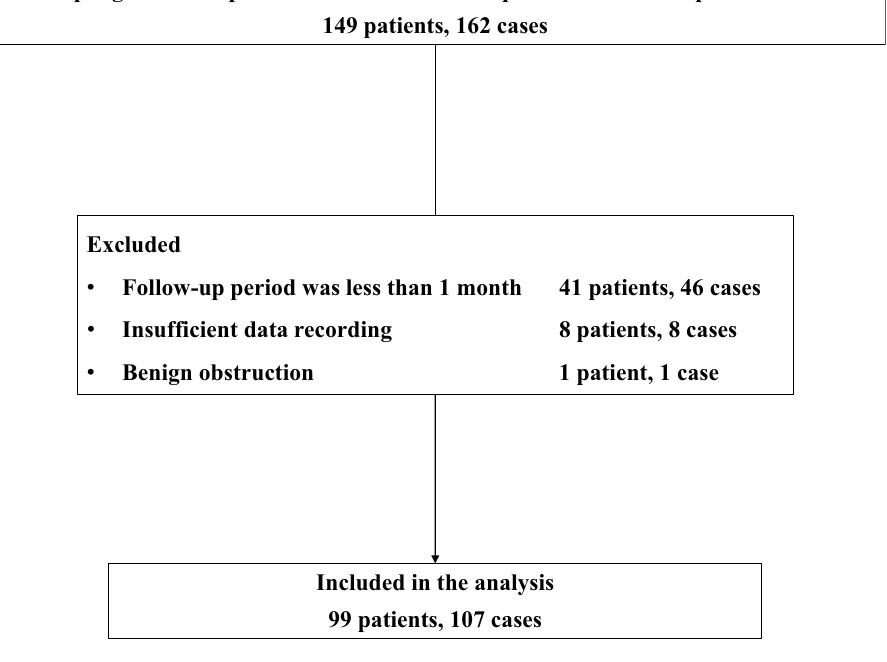
Figure 1. Patients’